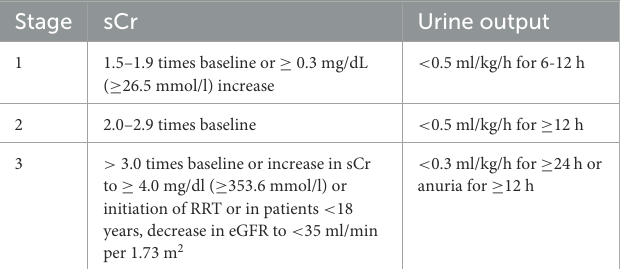
TABLE 1 KDIGO stages of AKI according to sCr levels and urine